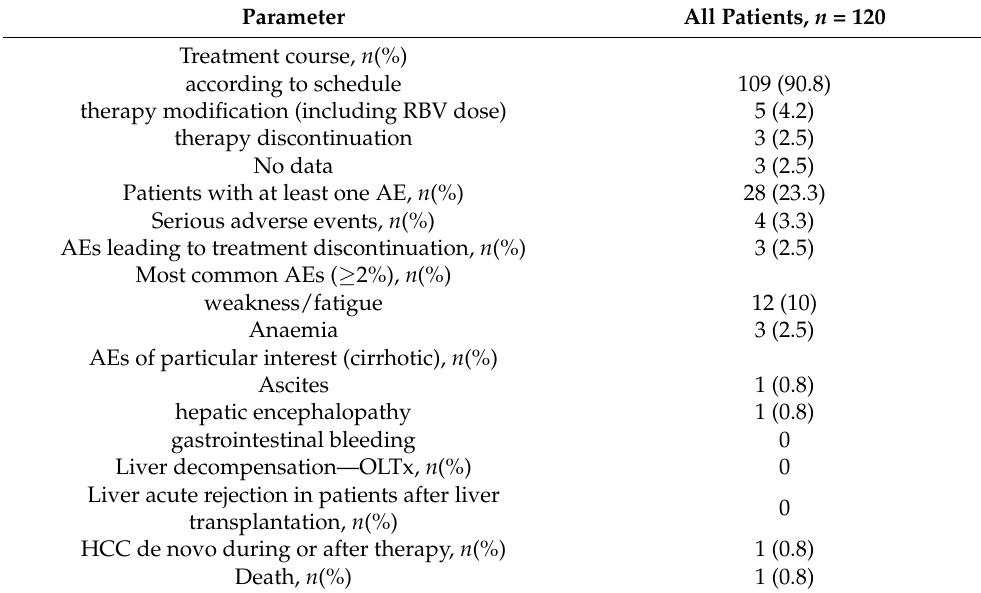
Table 7. Safety of antiviral